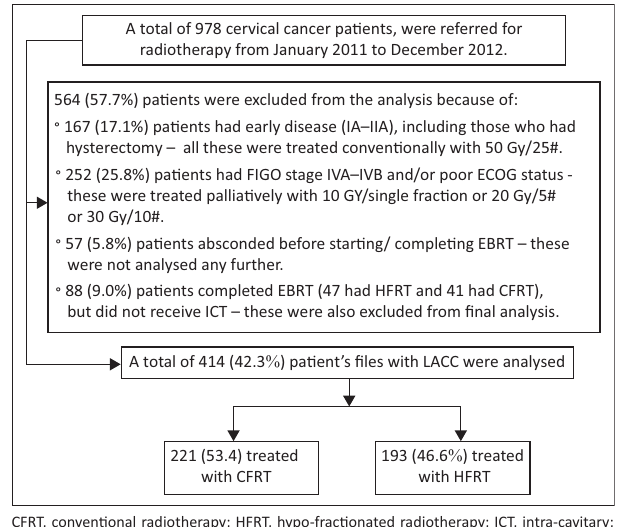
FIGURE 1 : Inclusion ad exclusion criterion of the